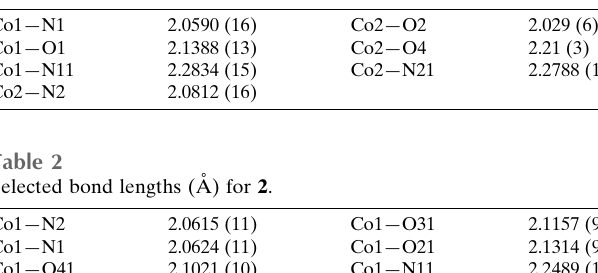
Table 3 Hydrogen-bond geometry (A˚ , (cid:5) ) for 1